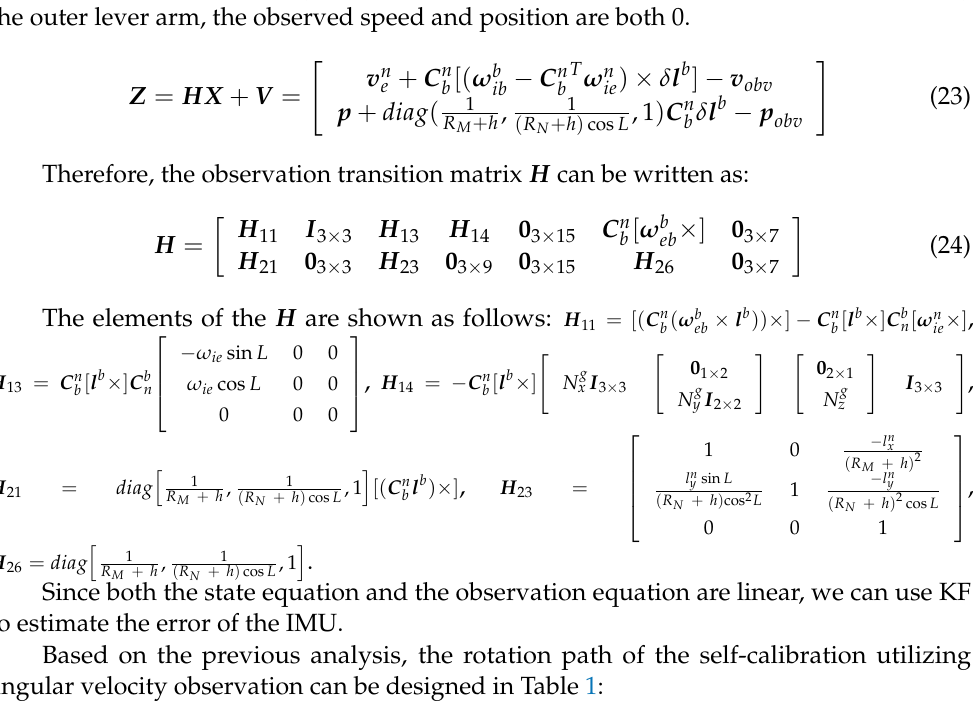
Table 1. Rotation path of self-calibration process. Rotation Axis (Inner (I) Time ( z -Axis of